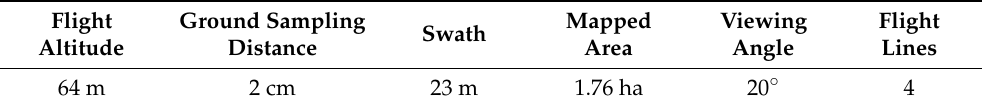
Table 2. Parameters of the aerial survey.